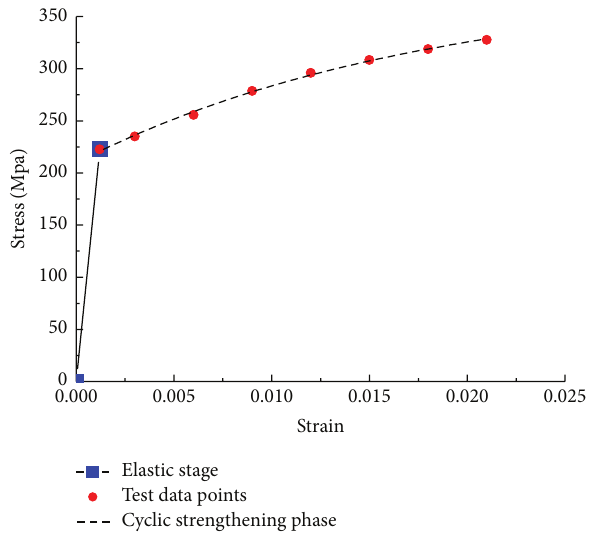
Figure 8: Model for skeleton curve of A11.